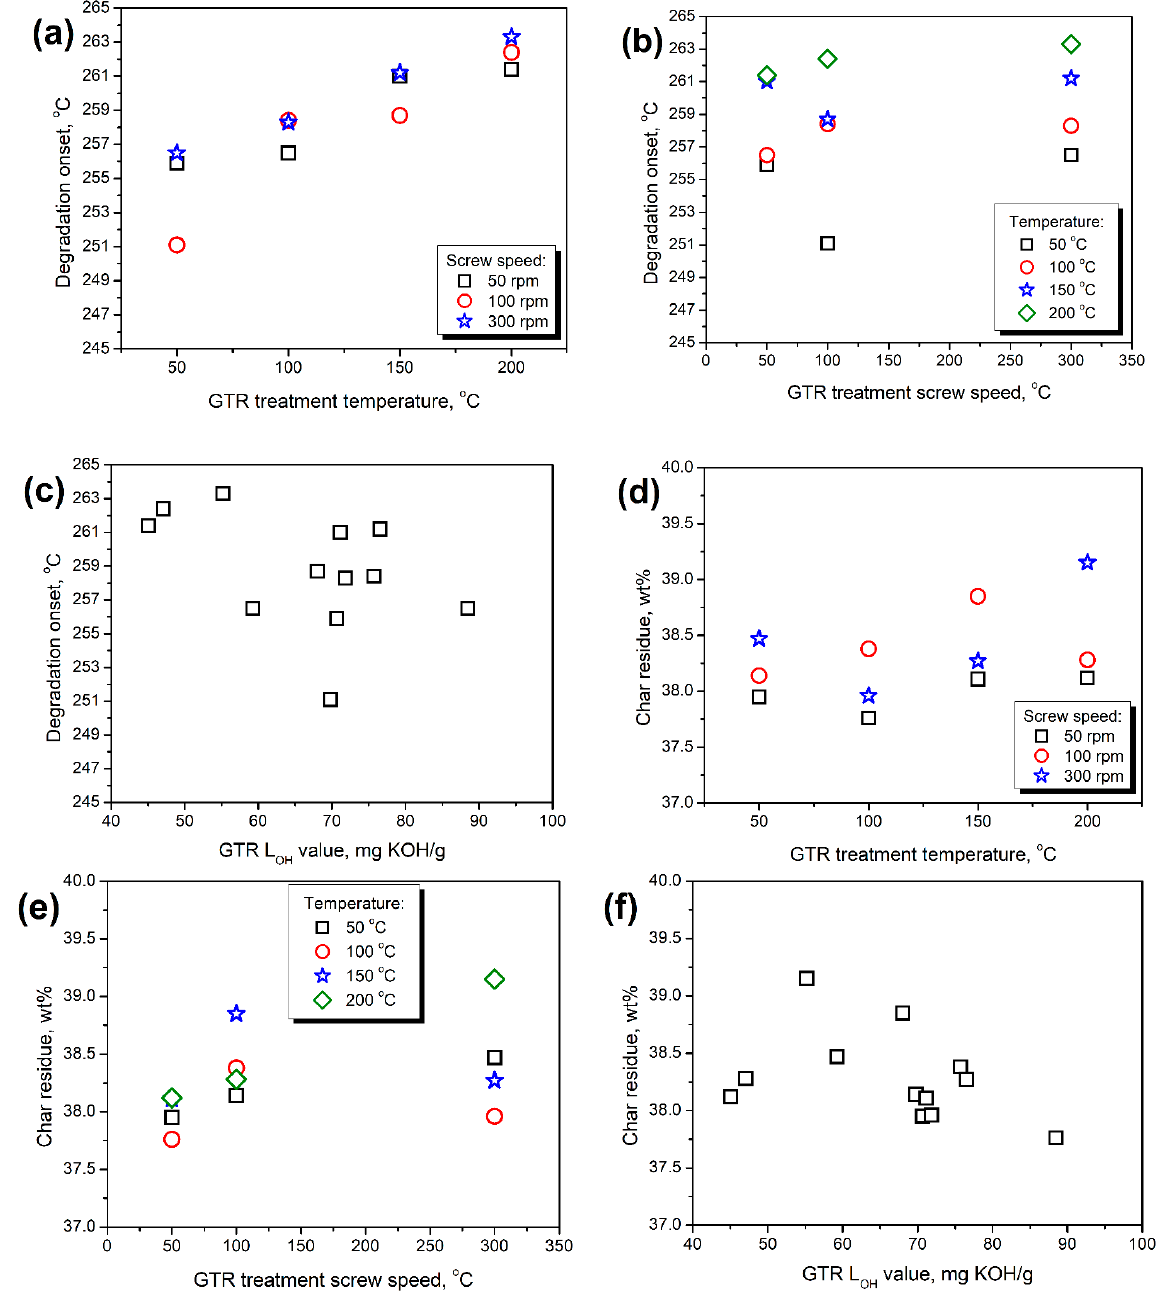
Figure 13. The impact of ( a , d ) GTR treatment temperature, ( b , e ) GTR treatment screw speed, and ( c , f ) GTR L OH value on the ( a , b , c ) degradation onset, and ( d , e , f ) char residue of applied GTR samples.